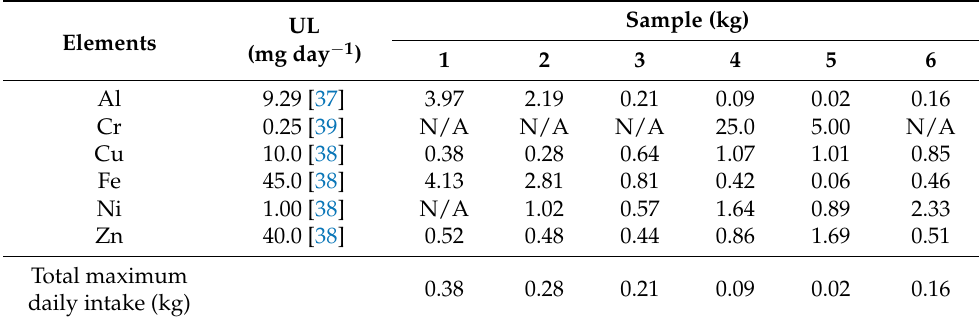
Table 4. Maximum daily intake of the six mushroom